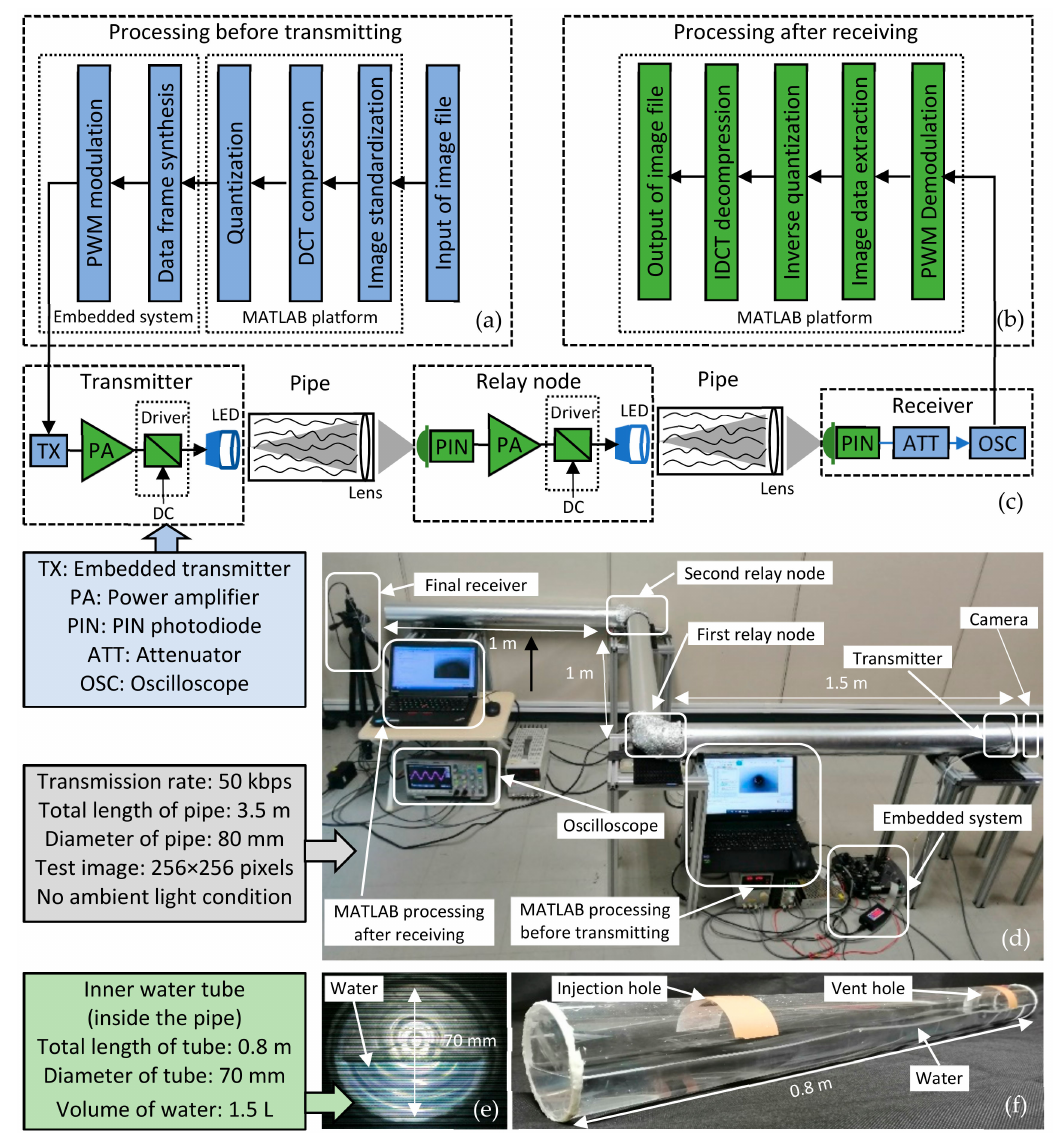
Figure 3. ( a – c ) Flow chart of digital image frame relay transmission (DIFRT), ( d ) setting up of DIFRT experiment, and ( e , f ) inner water